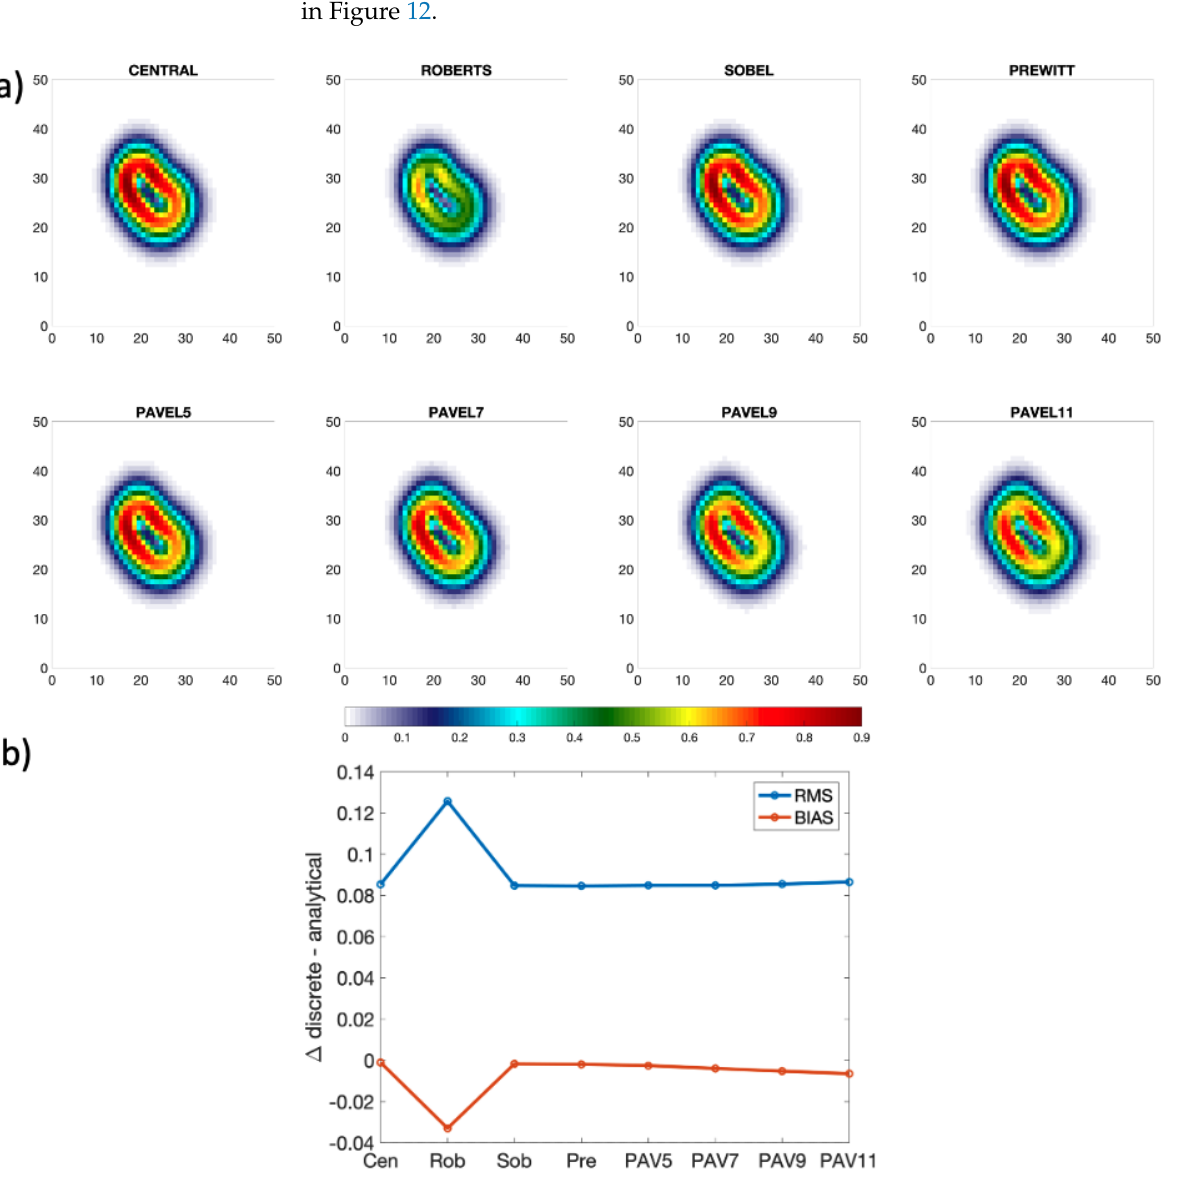
Figure 11. ( a ) Gradient intensities computed numerically using central, Roberts, Sobel, Prewitt and Pavel 5 to 11 schemes. ( b ) RMSE (blue) and bias (orange) of the numerically computed gradient with respect to the analytical ground truth value calculated from the noise-free temperature field using Equation (3), units are in K. The analyses refer to the ideal case: absence of